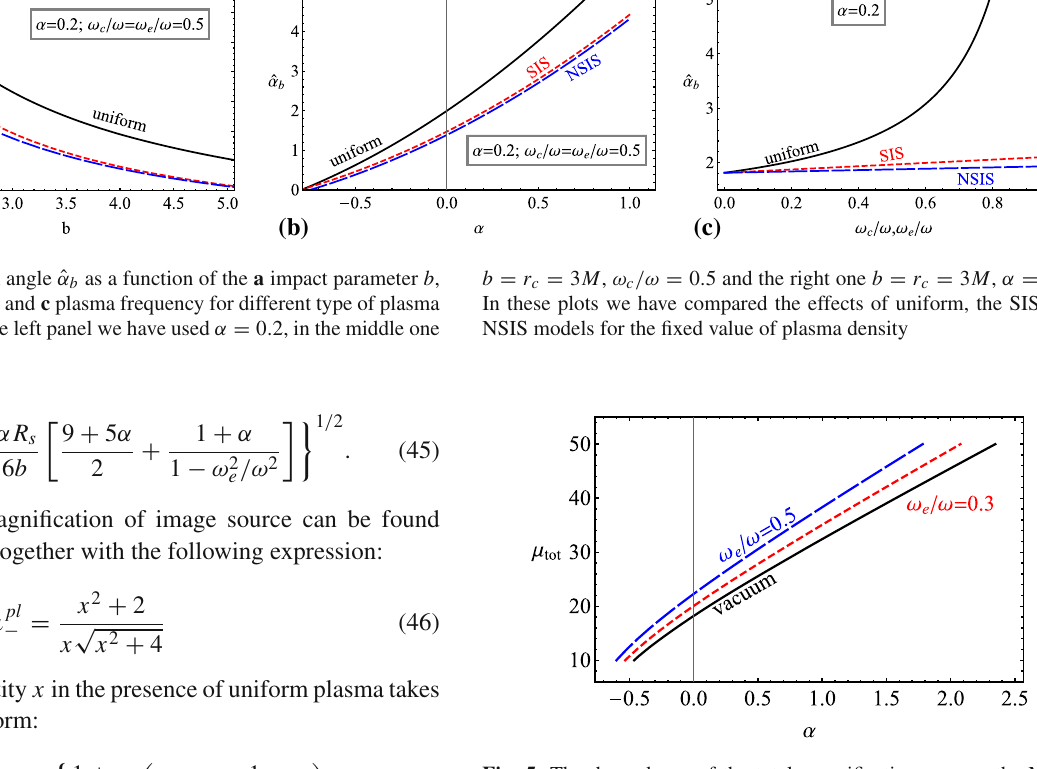
Fig. 3 Deflection angle ˆ α b as a function of the impact parameter b around MOG black hole surrounded NSIS plasma. In the left panel we have fixed the plasma frequency as ω c /ω = 0 . 5 by varying the MOG parameterwiththecomparisontheSchwarzschildcase,themiddlepanel